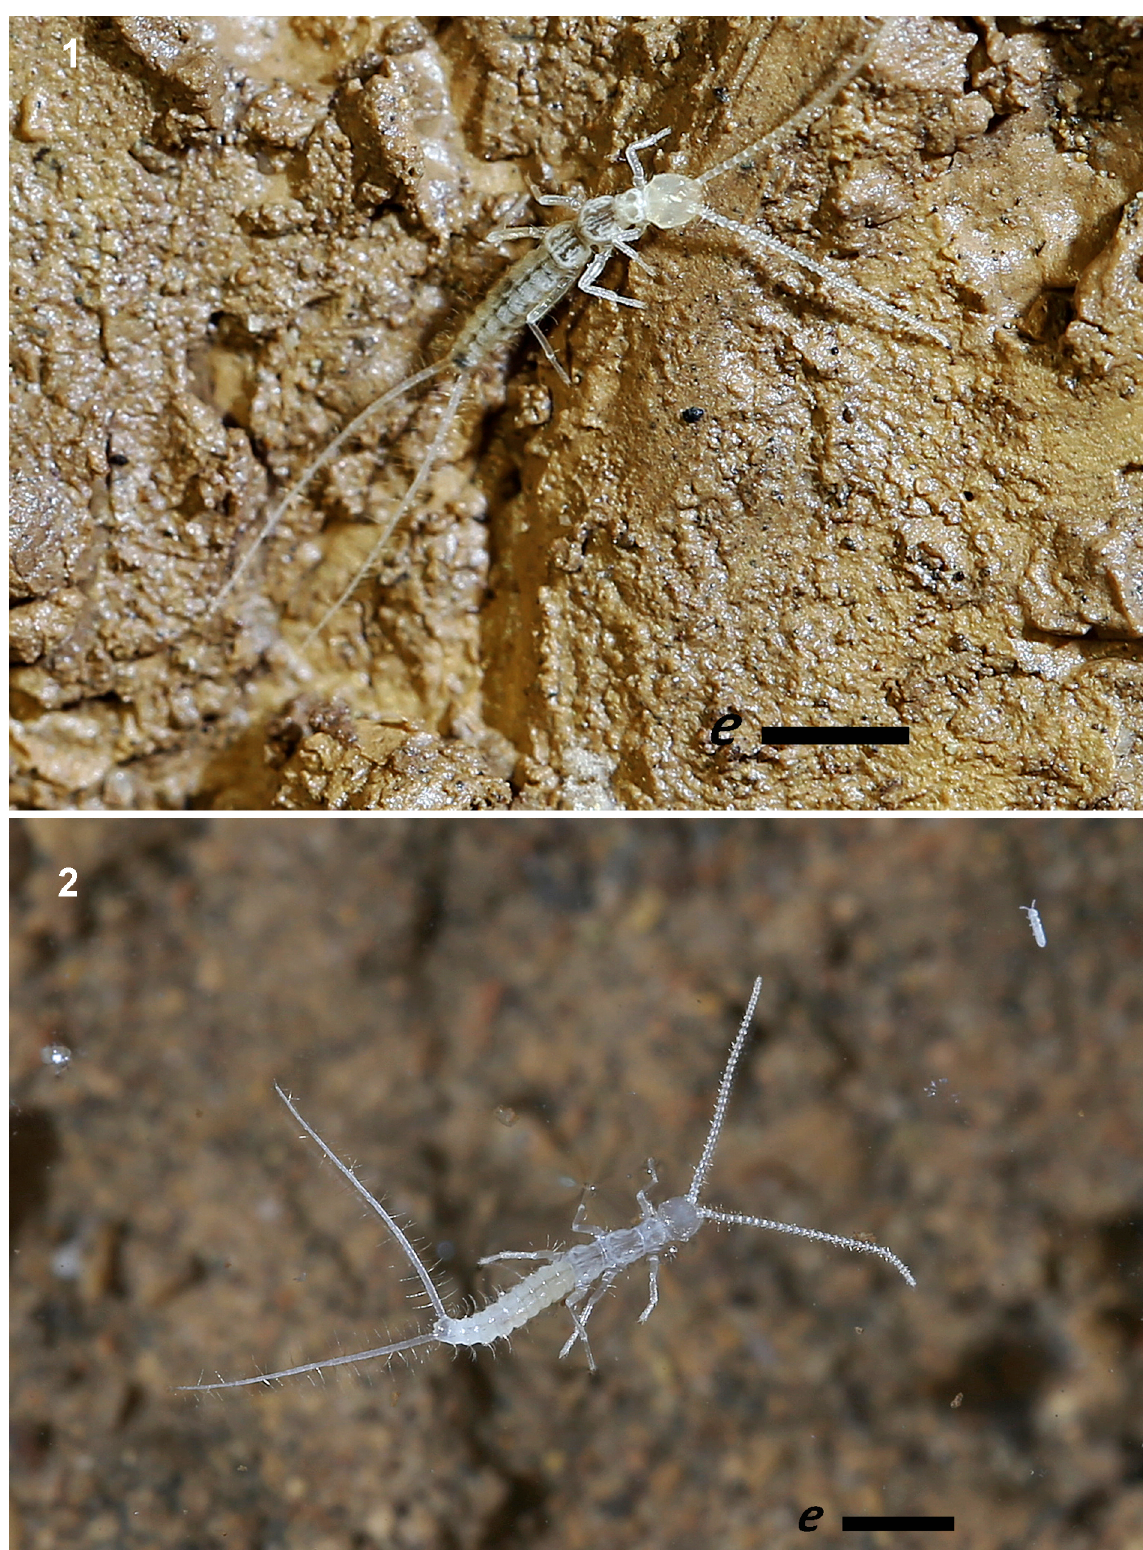
Figs 1–2. Plusiocampa (Pentachaetocampa) inopinata subgen. et sp. nov. 1 . On a clay surface. 2 . On the surface of a puddle from Schallsinger Höhle. Courtesy of Mirjam Widmer. Scale bars = 2